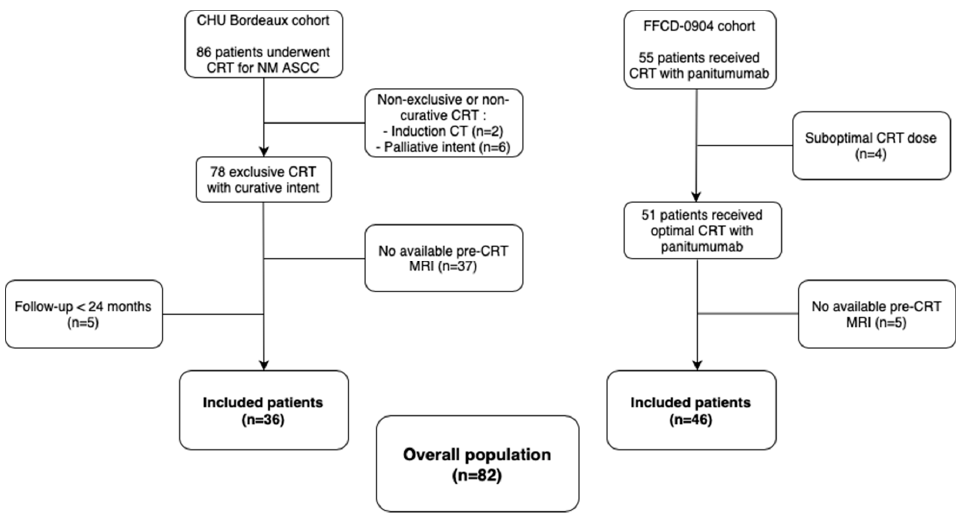
Figure 2. Flowchart of patient selection. (Abbreviations: CRT = chemo-radiotherapy, NM = non-metastatic, ASCC = anal squamous cell cancer, CT = chemotherapy, MRI = magnetic resonance imaging). Table 1. Patient and tumor characteristics in the two subsequently blended cohorts. (Abbrevia-